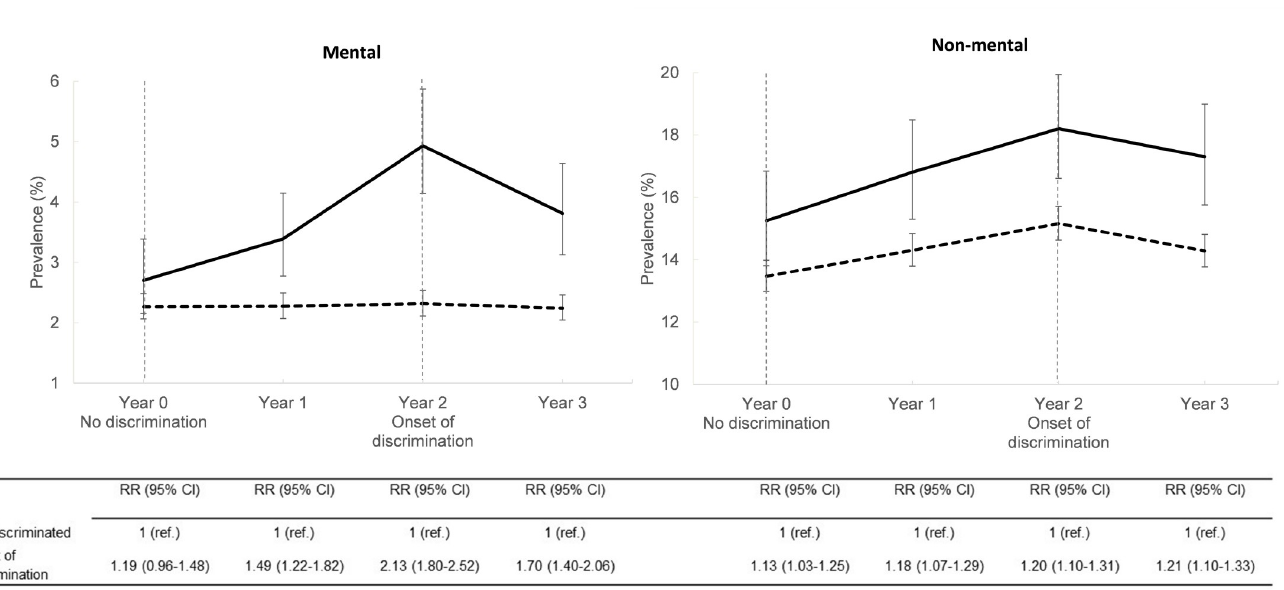
Fig 1. Prevalence of long-term sickness absence among employees with and without onset of workplace discrimination as well as the risk ratio (RR) and 95% CI’s associated with onset of workplace discrimination. Log-binomial regression analyses adjusted for the following variables at year 0: Age, sex, chronic disease, psychological distress, anxiety, BMI, alcohol consumption, shift work, employment contract, occupational grade, work-unit size, work-unit temporary employment, work- unit gender distribution, as well as data-cycle number. Solid lines represents those with onset of workplace discrimination and dashed lines represents those who were not